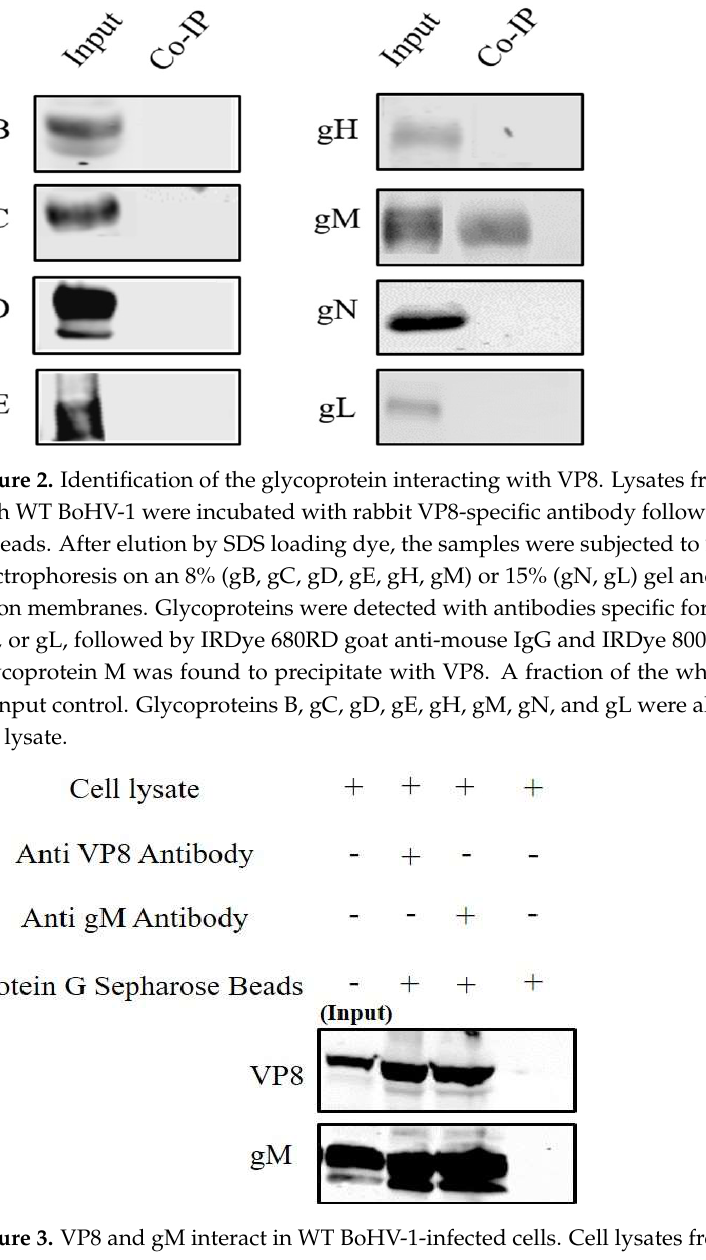
Figure 3. VP8 and gM interact in WT BoHV-1-infected cells. Cell lysates from MDBK cells infected with WT BoHV-1 were incubated with VP8-specific or gM-specific antibodies, followed by Protein Sepharose G beads or with Protein G Sepharose without antibodies. After elution by SDS loading dye, the samples were subjected to SDS-polyacrylamide gel electrophoresis on an 8% gel and transferred to 0.45 µ m nylon membranes. A fraction of the whole cell lysates was used as input control. VP8 and gM were detected with monoclonal anti-VP8 and rabbit anti-gM antibodies, followed by IRDye 680RD goat anti-mouse IgG and IRDye 800RD goat anti-rabbit IgG, respectively.